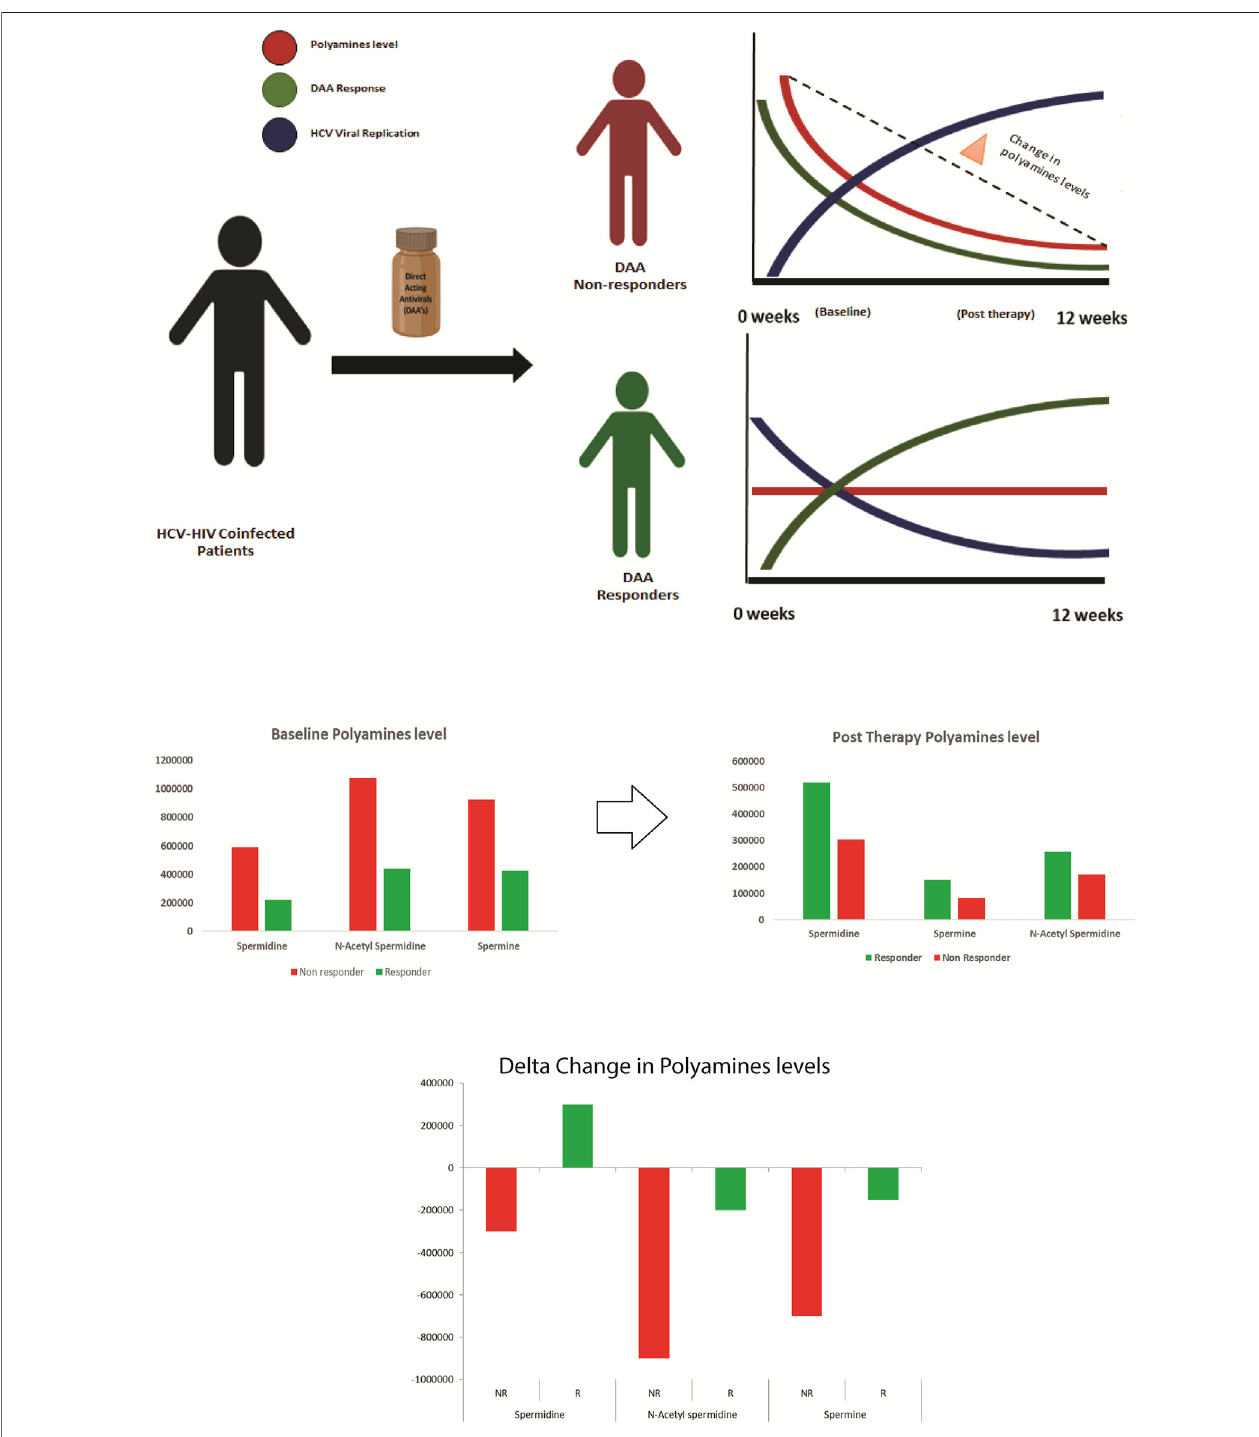
FIGURE5| ParadigmofDAAnonResponse:Metabolomicsanalysisshowsthatdecrease inpolyaminesfrombaselinetoposttherapycorrelateswiththeincrease in viral replication and DAA non response. Thus baseline measurement of polyamines is crucial for segregating patients predisposed to DAA non response.